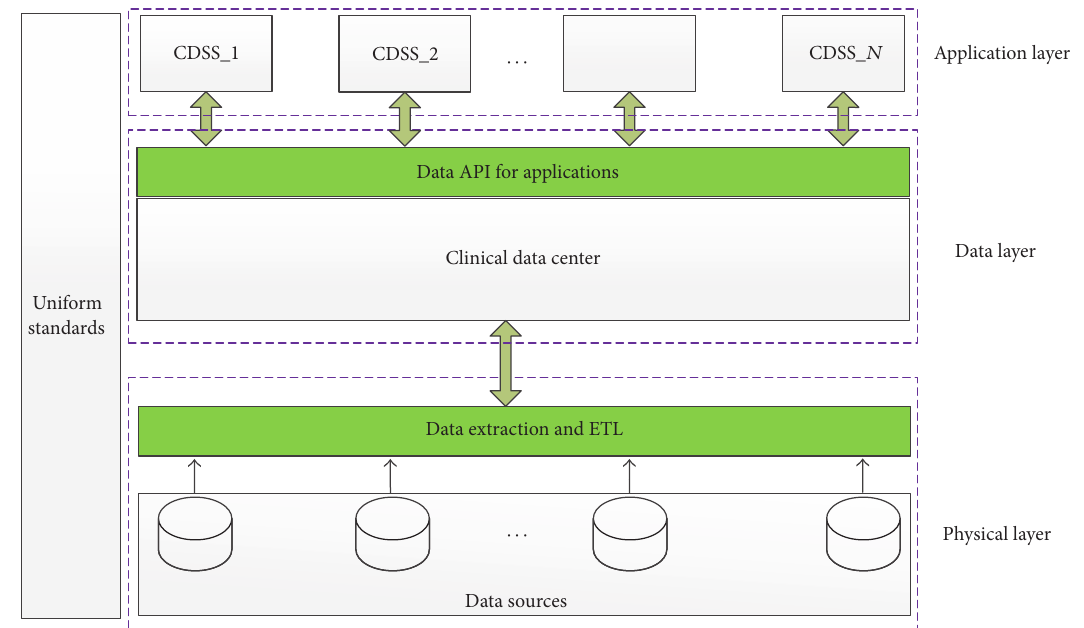
Figure 1: Architecture of a CDSS for comorbidity monitoring.